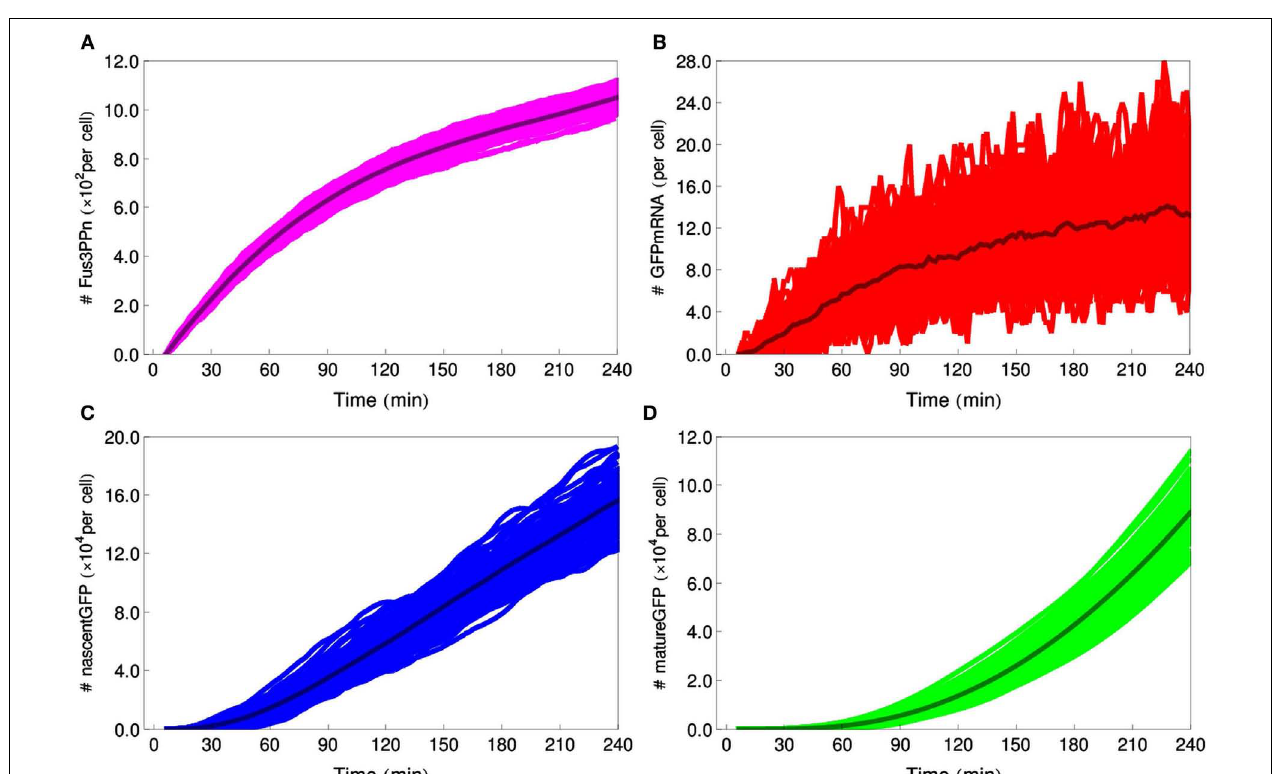
species: (A) number of Fus3ppn molecules per cell, (B) GFP-mRNA molecules, (C) nascent GFP polypeptides, (D) mature GFP